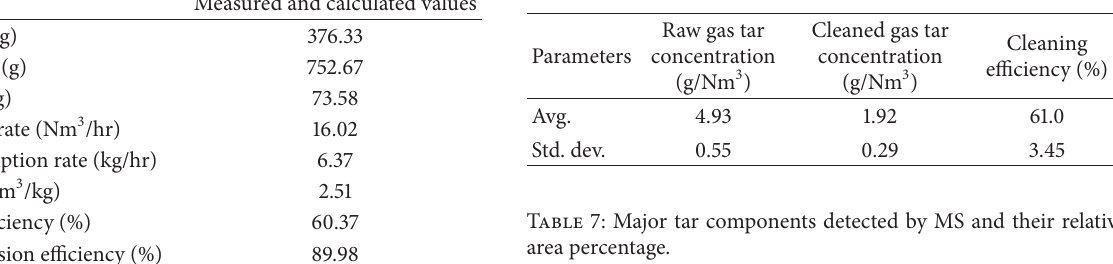
Table 5: Gasification performance. Table 6: Tar concentrations measured in raw and cleaned syngas and gas cleaning efficiency.